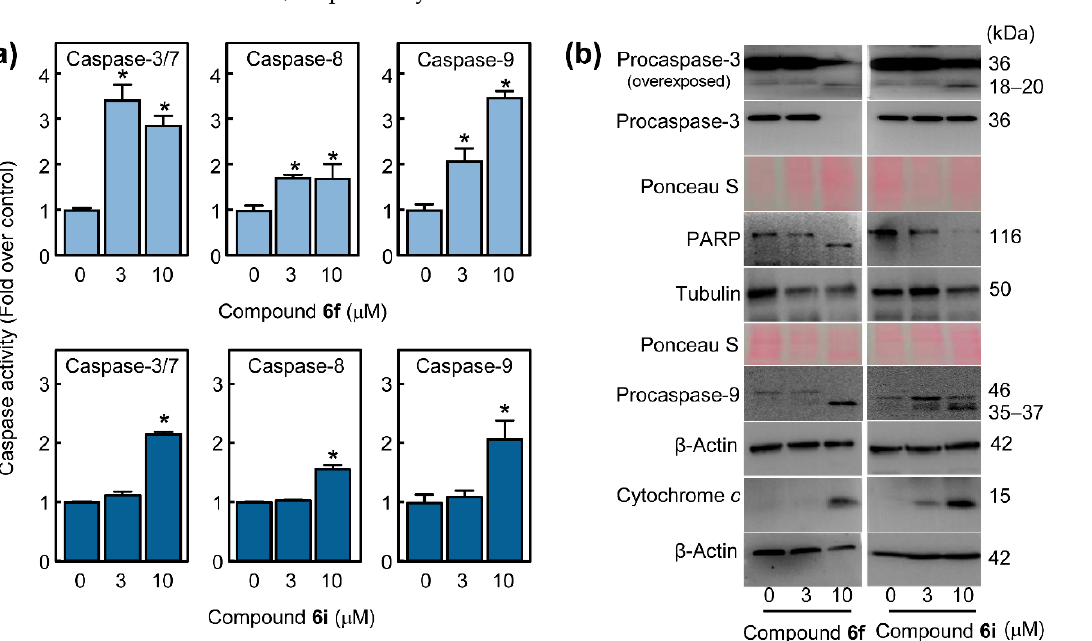
of cells in the sub-G 1 region using flow cytometry after propidium iodide staining. * indicates p < 0.05 for comparison with untreated control, C. ( b ) Representative histograms of flow cytometry using propidium iodide staining of cells incubated in the presence of 10 µ M of the indicated compound for 24 h. The percentage of sub-G 1 cells is shown. ( c ) Cells were incubated as indicated in ( b ) and quantified by flow cytometry after double staining with annexin V-FITC and propidium iodide. Cells in the lower right quadrant show positive annexin V-FITC, which indicates phosphatidylserine translocation on the outside of the plasma membrane, and negative propidium iodide staining, which demonstrates intact cell membranes, both features of early apoptosis. Cells appearing in the top right quadrant are double positive for annexin V-FITC and propidium iodide and are undergoing late apoptosis. Data are representative of three independent experiments. ( d ) PBMC were incubated with increasing concentrations of compounds 6f and 6i for 24 h and quantified by flow cytometry after double staining with annexin V-FITC and propidium iodide.